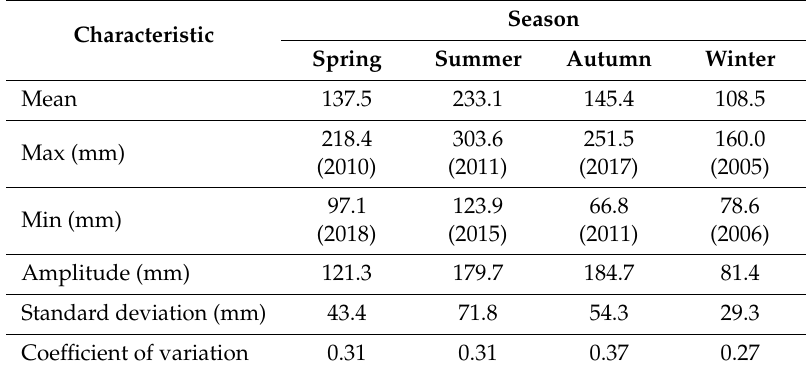
Table 2. Selected characteristics of seasonal and annual atmospheric precipitation totals averaged across Poland in